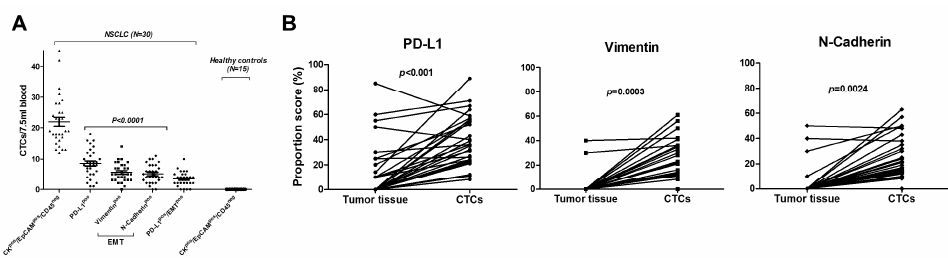
Figure 3. CTC counts, and comparative CTC expression and patient-matched tumor tissue analysis for PD-L1, vimentin, and N-Cadherin in NSCLC patients ( N = 30). ( A ) Counts per 7.5 mL of blood of traditional CK pos / EpCAM pos / CD45 neg CTCs are shown. CTC positive expression for